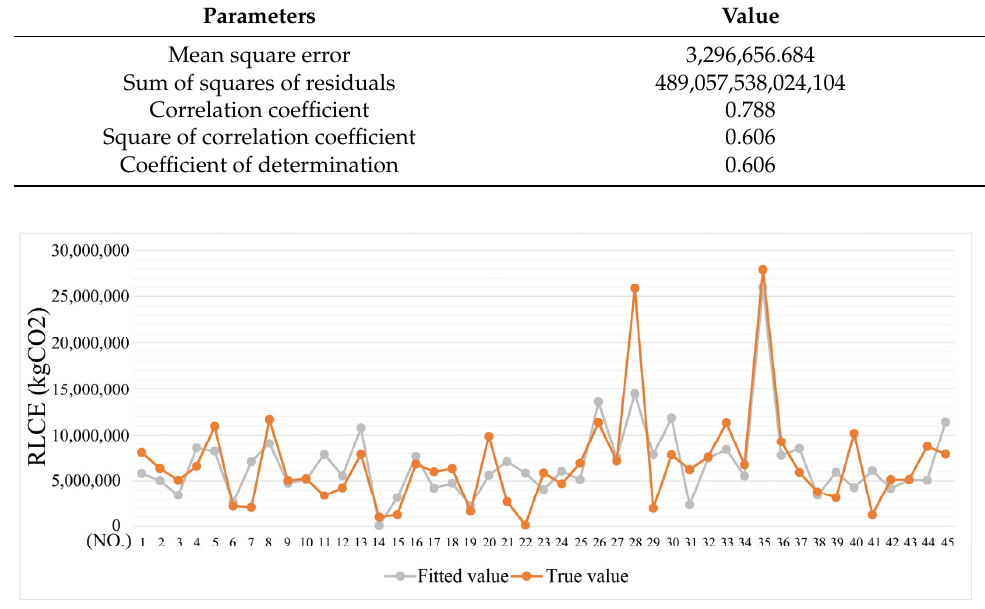
Figure 6. Regression of